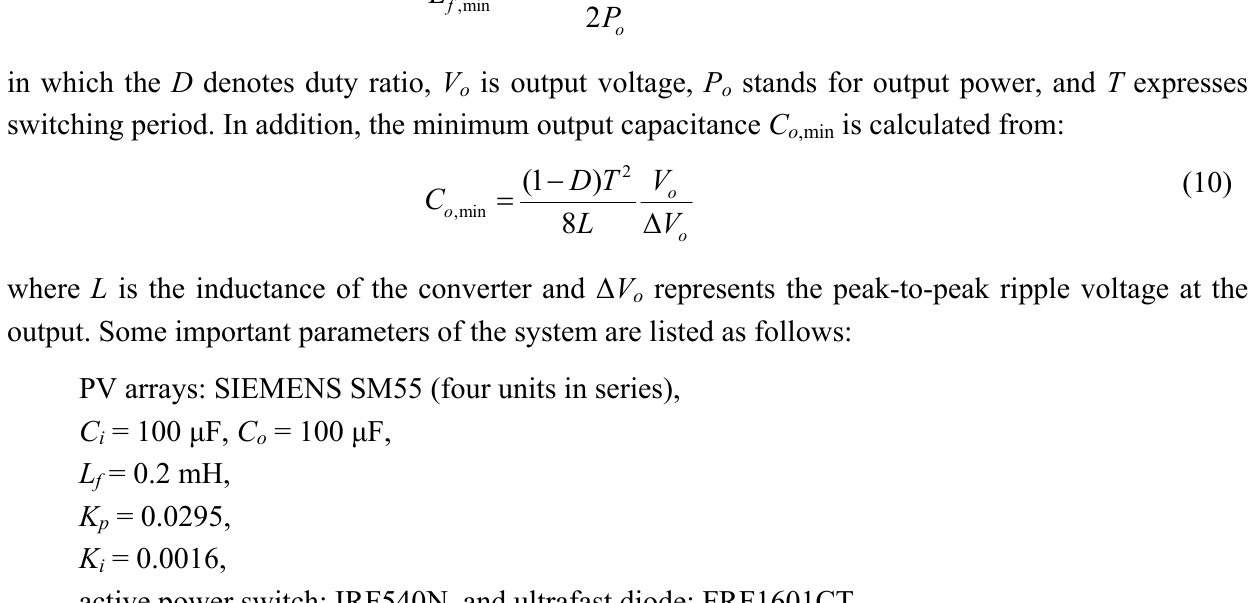
Figure 9. Illustration of an implementation example which controls PV voltage to fulfill MPPT feature with the proposed DLAA circuit.